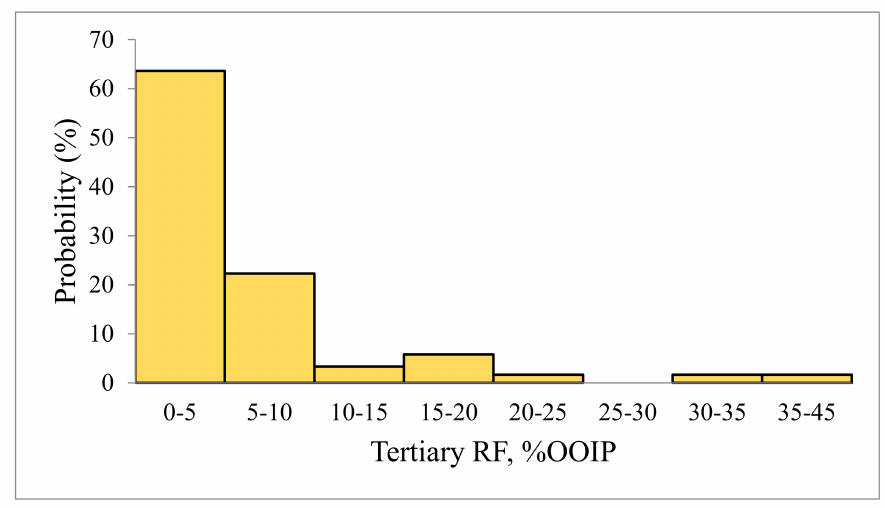
Figure 1. Probability of incremental recovery factor achieved by tertiary stage injection,